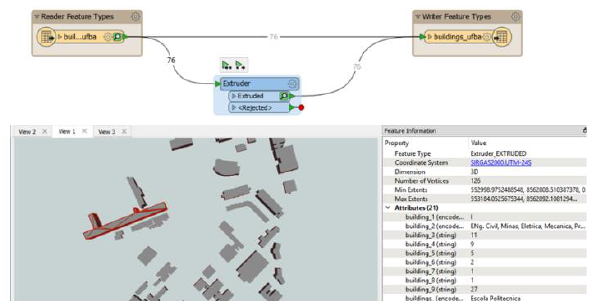
Figure 16: Conversion of the Collada format to CityGML and visualization of the model in FME